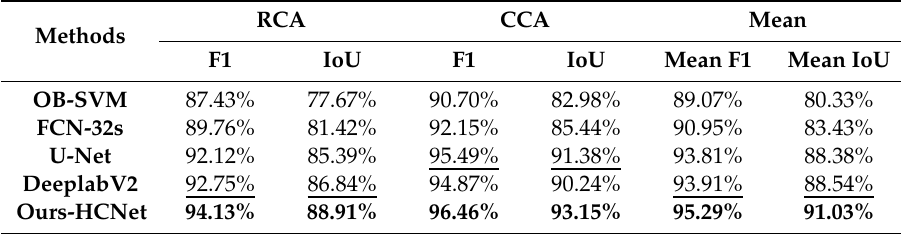
Table 4. Quantitative comparison between our method and other methods at the pixel level, where the best values in bold and the second-best values are